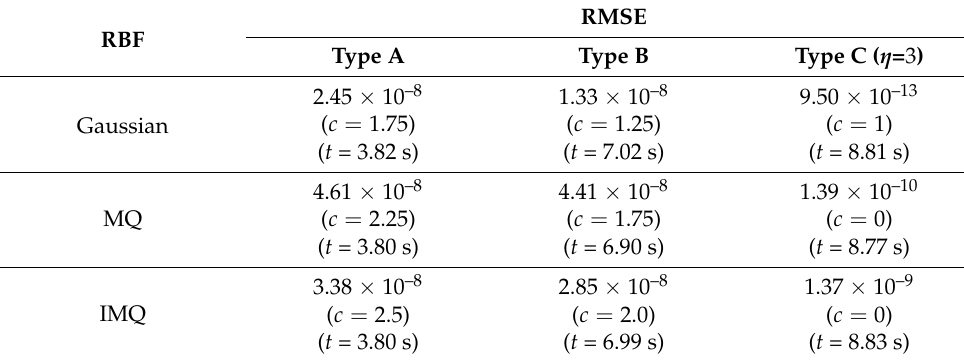
Figure 7. RMSEs of three RBFs with three different collocation types: ( a ) Gaussian RBF, ( b ) MQ RBF, and ( c ) IMQ RBF. Table 3. Comparison of the results for the application example